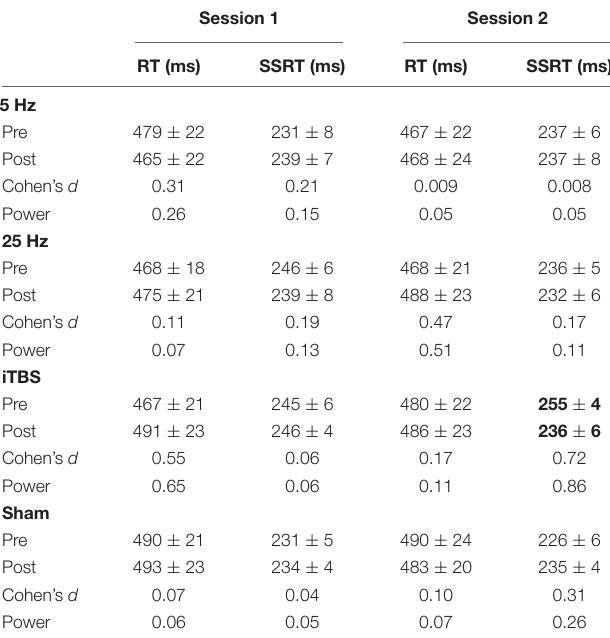
TABLE 1 | Stop signal measures in the first experiment.